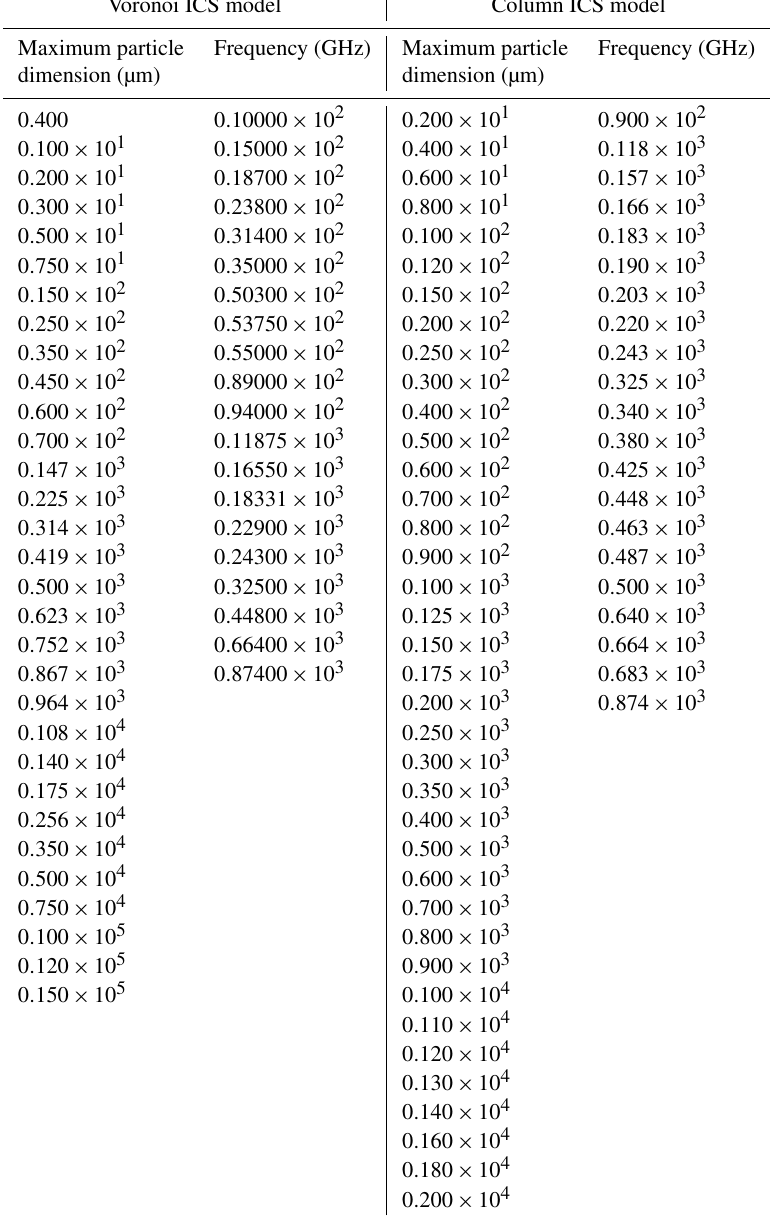
Table 1. The frequency channels and maximum particle dimensions of ice particles included in the single-scattering property database of the Voronoi and column ICS